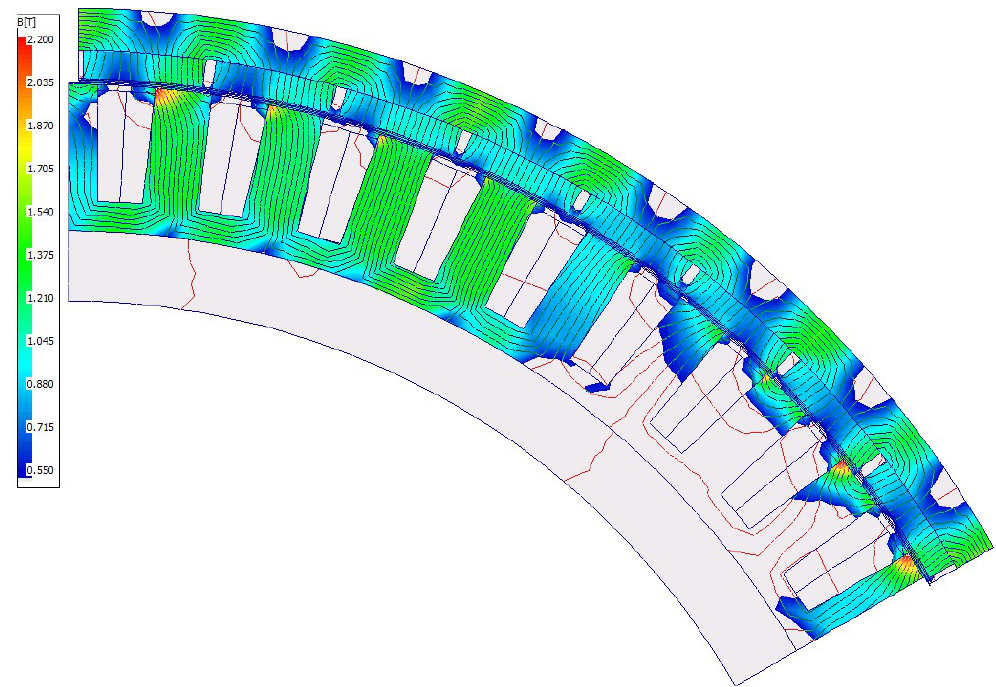
Figure 40. Calculated magnetic induction distribution of the motor with axial segmentation of magnets (x5) in the 847th second of the Artemis Motorway150 cycle duration with the operating parameters: v vehicle = 150.4 km/h; n = 1140 rpm; T m = 596 Nm; I RMS = 94 A, α phase advance = 27.8°) .